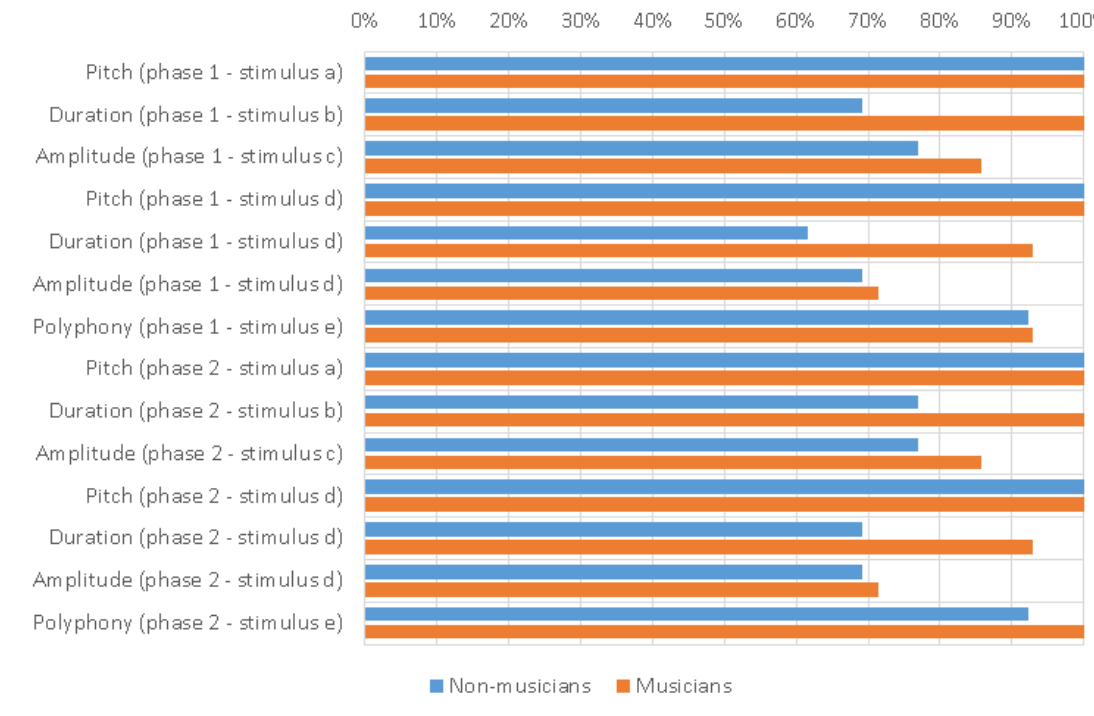
Figure 10. Relative frequencies of musical parameter variation perception on all stimuli across both experiment phases. n (non-musicians) = 13; n (musicians) =